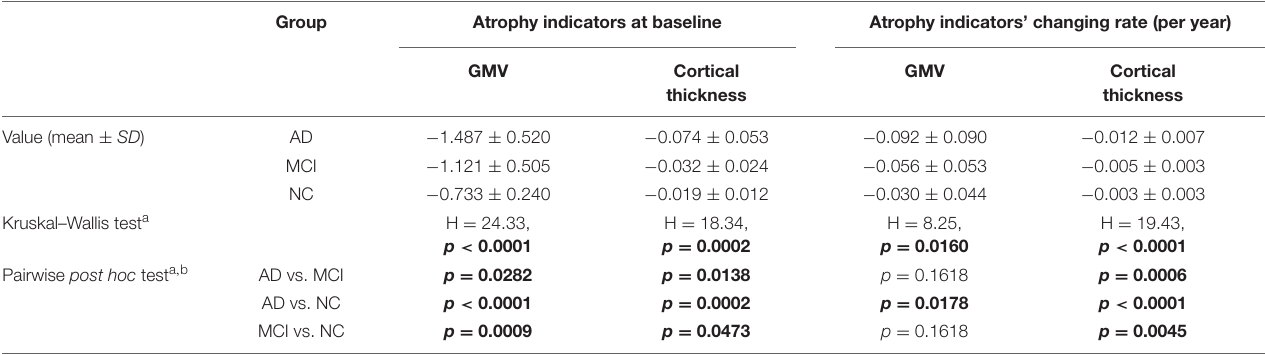
TABLE 2 | Statistic results of the baseline atrophy indicators and their longitudinal changing rate for AD, MCI, and NC group. Group Atrophy indicators at baseline